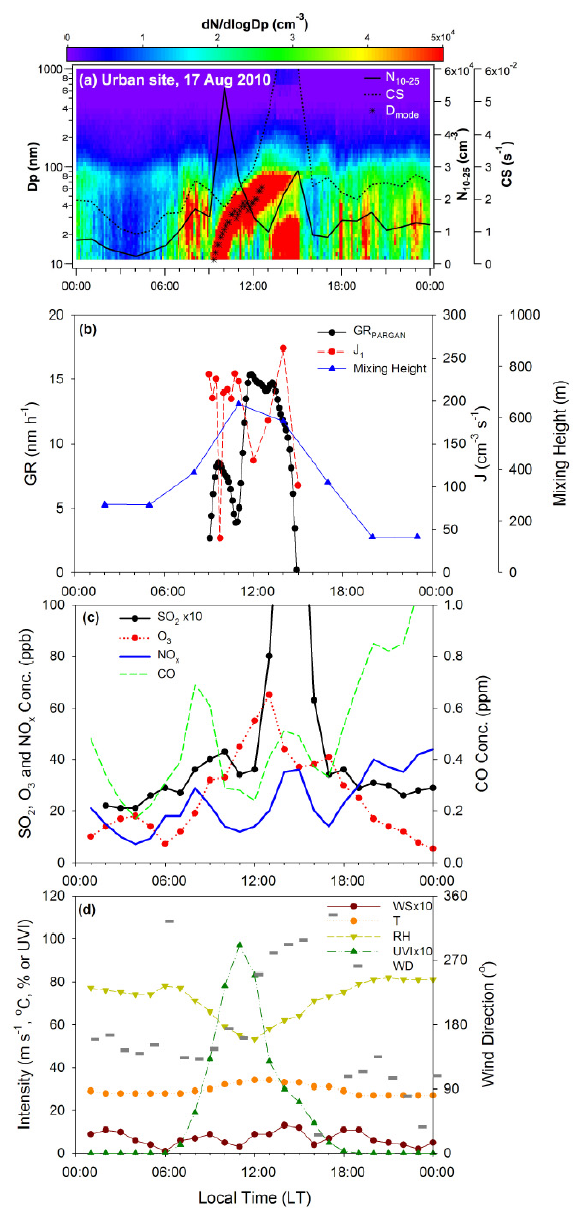
Fig. 3. The evolution of (a) the number size distributions, N 10 − 25 , CS and particle mode diameter ( D mode ) , (b) the GR PARGAN , J 1 and mixing height, (c) the hourly SO 2 , O 3 , NO x and CO, and (d) the meteorological conditions (WS, T , RH, WD and UVI) during a morning NPF and growth event on the 17 August